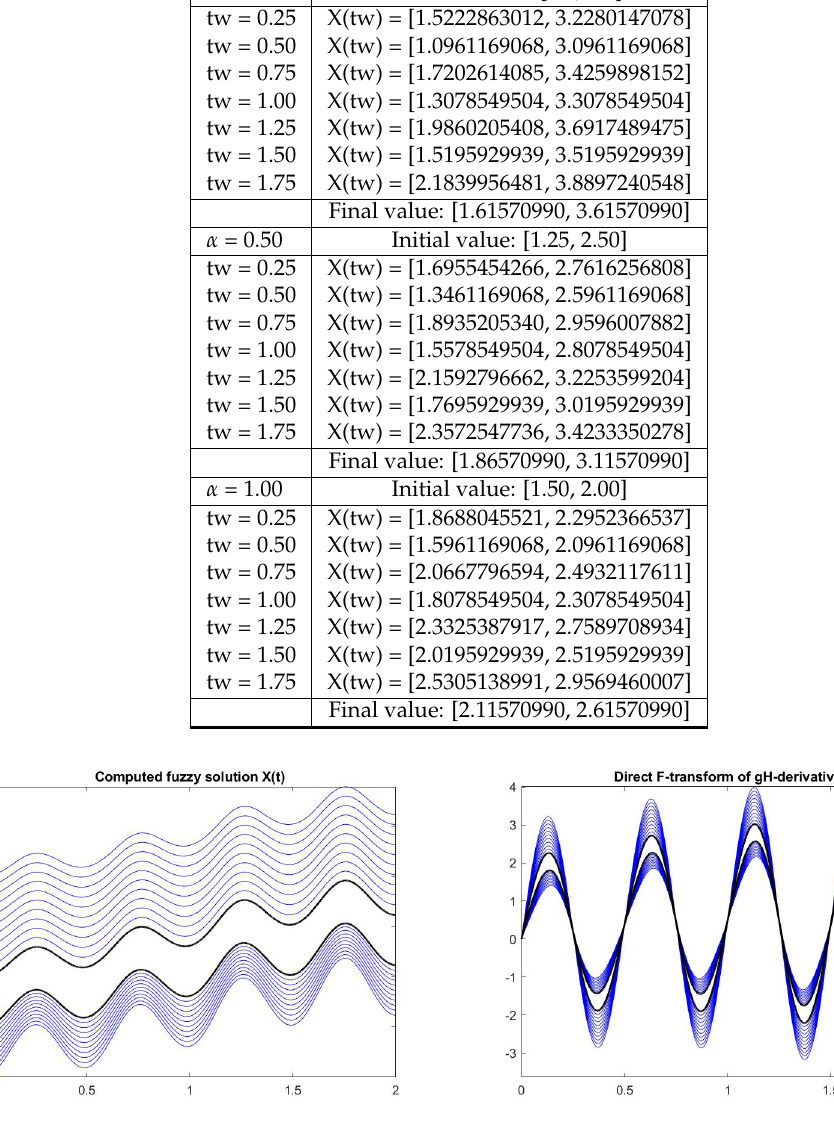
Figure 10. Problem IDE1, Meth = 2: Level-wise LgH-differentiable solution ( left ) and its LgH-derivative ( right ). There are seven switching points which are in the same position for all level α and correspond to the values of t where the gH-derivative is